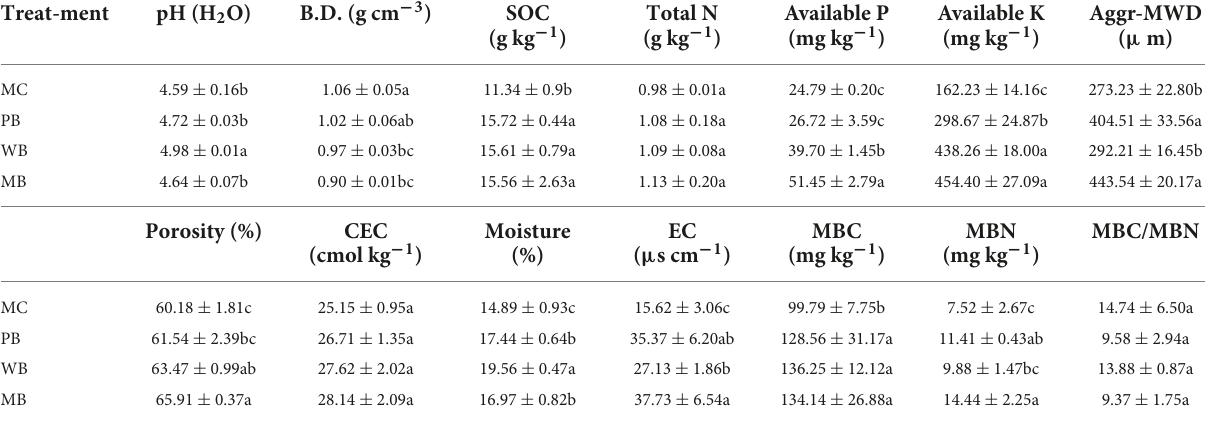
TABLE 2 Basic properties of topsoil (0–15 cm) sampled at ginseng harvest 3-year following organic amendment at 20 t ha − 1 .